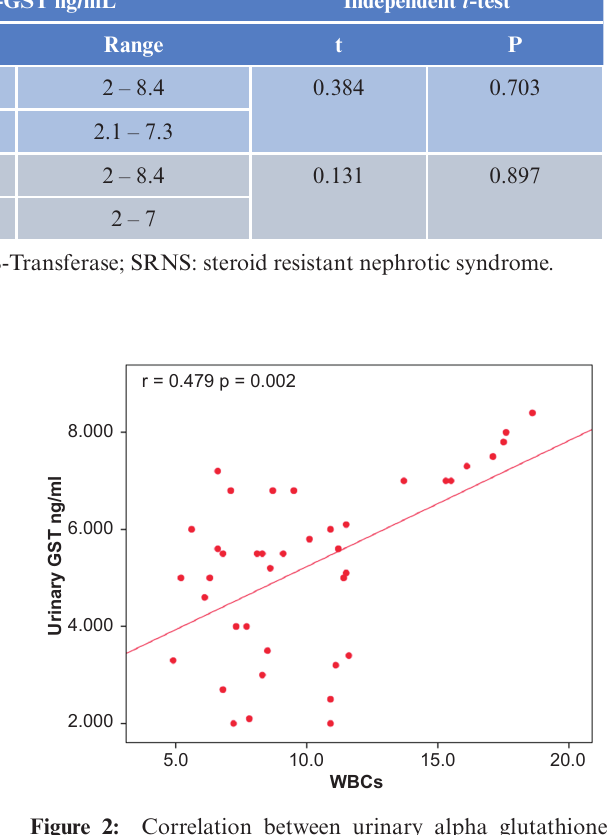
Figure 2: Correlation between urinary alpha glutathione S-transferase and white blood cells.